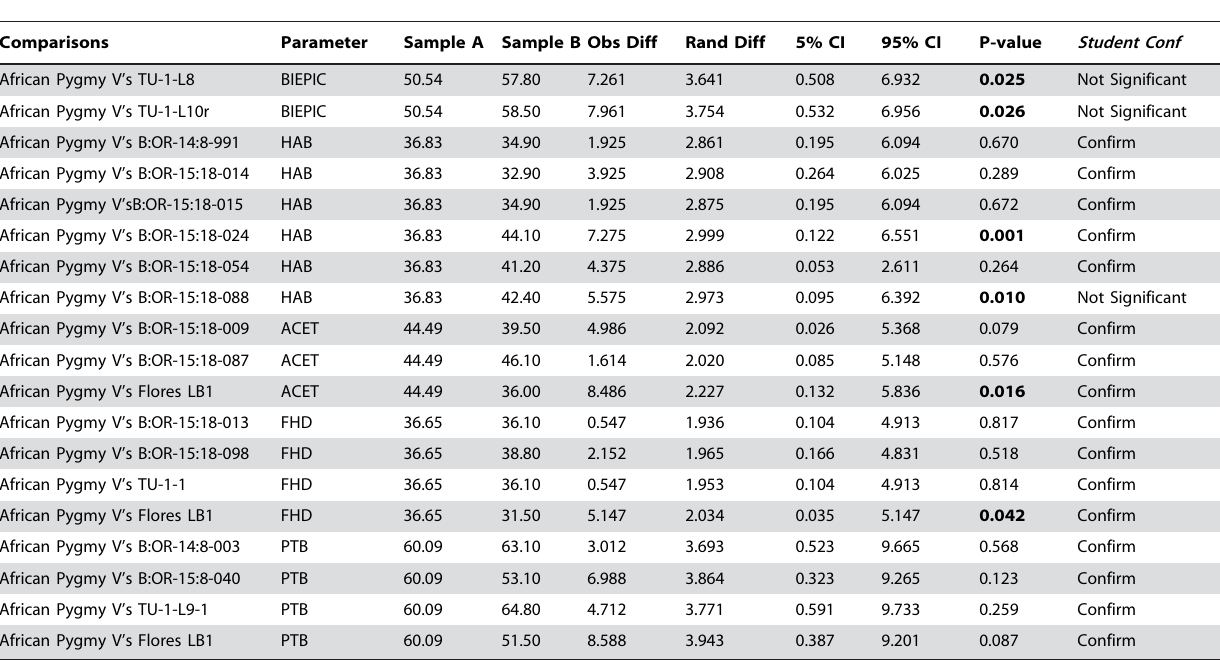
Table 2. Pairwise randomization comparisons of Palau and LB1 specimens.